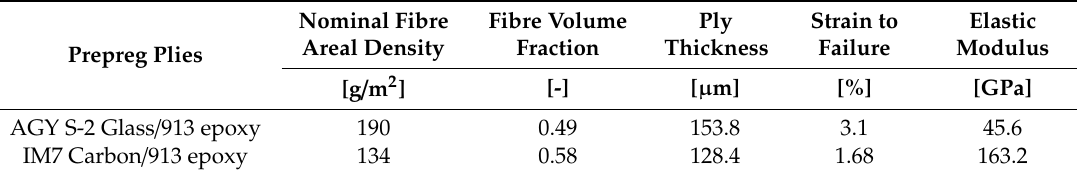
Table 2. Cured ply properties of unidirectional fibre-reinforced prepregs from the manufacturers’ datasheets.